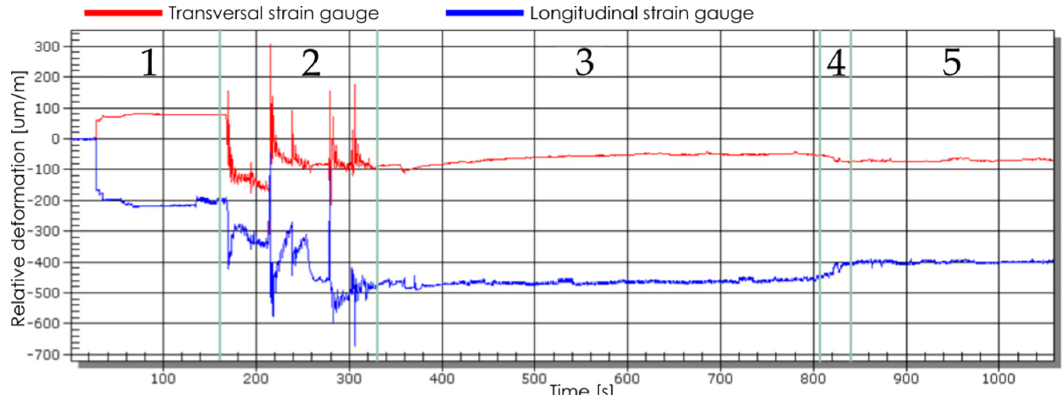
Figure 7. An exemplary course of the change of the relative deformation value in time: 1—fastening the sample in the clamping device, 2—the phase of the influence of disturbing factors, 3—milling process, 4—unfastening the sample from the clamping device, 5—stabilisation.